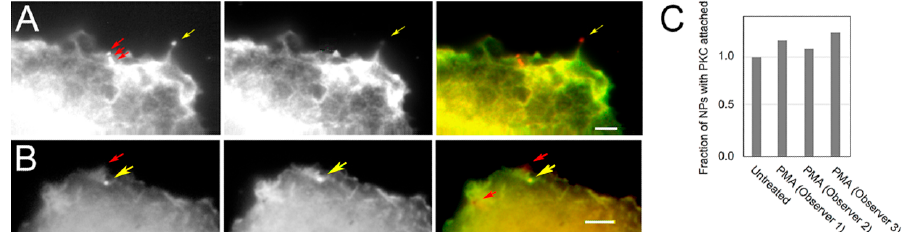
Figure 2. Colocalization of epidermal growth factor (EGF)-tagged nanoparticles and PKC- ε ( A , B ) EGF- and Cy3-labeled nanoparticles (left panel, red), PKC (center panel, green), and overlaid images (right panel) of cells fixed 5 min after re-warming. ( A ) Three single nanoparticles (red arrows) are present as well as a cluster of nanoparticles at the tip of a filopodium (yellow arrows). ( B ) PKC is concentrated at a single, in-focus nanoparticle (yellow arrows) while out-of-focus nanoparticles can be detected on ruffles (red arrows). ( C ) Counts of EGF-coated nanoparticles overlaid with PKC localized by the Genetex green (GG) procedure. The phorbol ester exposure had little effect on recruitment of the GG form of PKC to nanoparticles. (A–B) Bars = 3 µm.